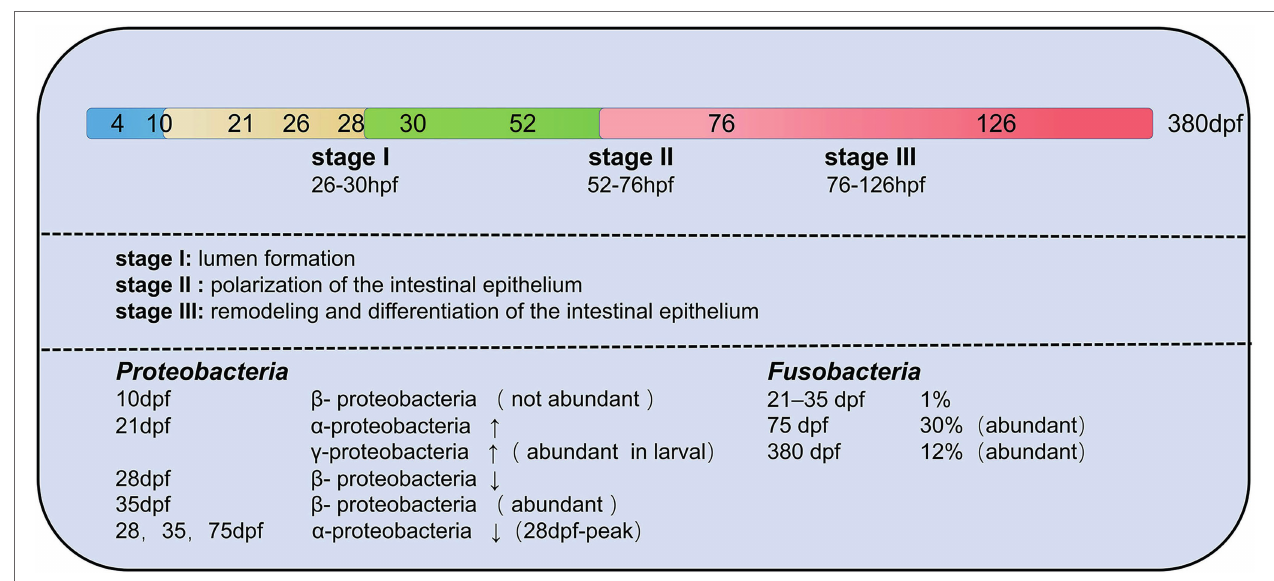
FIGURE 4 | Changes in the composition of gut microbiota of zebrafish at different developmental stages. A total of three transitions of gut microbiota occurred throughout the developmental stages. The first transition of gut microbiota occurs at 10 days post-fertilization (dpf), the second transition of gut microbiota from embryo to juvenile occurs at 35–75 dpf in zebrafish, and the last transition of gut microbiota is from juvenile to early adult at 76 dpf–126 hpf. Proteobacteria and Fusobacteria are the two main core groups of zebrafish at different developmental stages, but both show different changes (increasing or decreasing) in different developmental